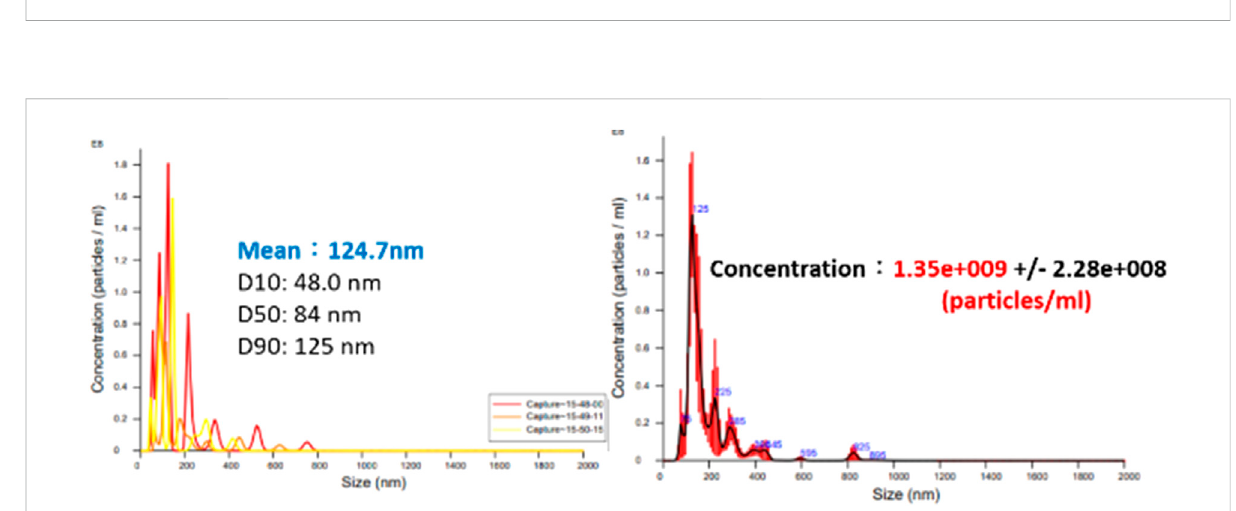
FIGURE 6 Bubble size and concentration measuring result for nanobubble liquid of porous disc rotary cutting.